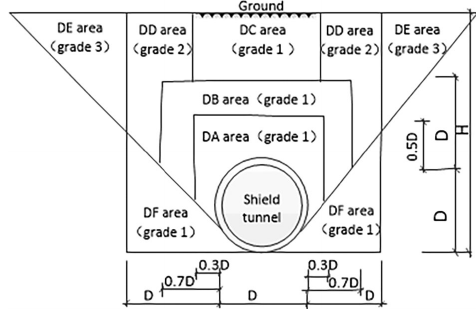
Figure 4. Grading diagram for working condition (1,